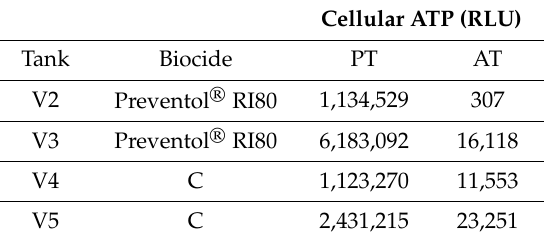
Table 6. Evaluation of the biocidal activity of Preventol ® RI80 and cinnamon essential oil (C) through bioluminescence assays. (PT: pretreatment, AT: after treatment).